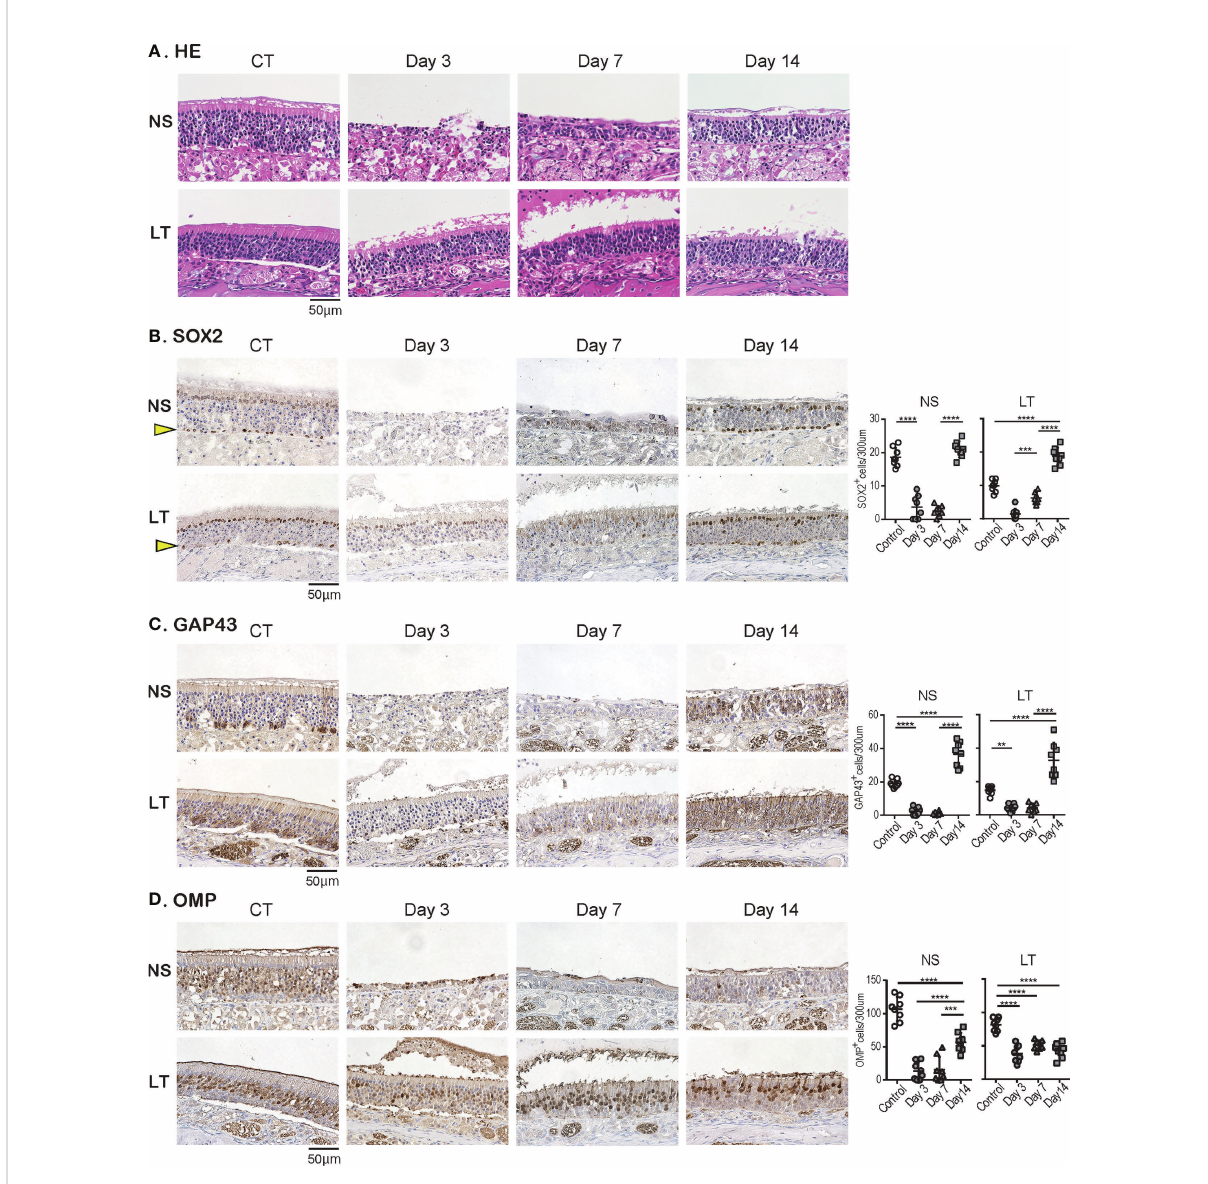
FIGURE 4 Effects of SARS-CoV-2 infection on the olfactory receptor neuron lineage. (A) Representative hematoxylin and eosin staining (HE) images of the olfactory epithelium in control (CT) hamsters and SARS-CoV-2 hamsters on days 3, 7, and 14. (B-D) : Representative images of immunohistological staining in CT and SARS-CoV-2 hamsters. Nasal septum (NS) area and lateral turbinate (LT) area are shown in magni fi ed view. Sex-determining region Y-box 2 (SOX2) + progenitor cells (B) , growth-associated protein 4 (GAP43) + immature olfactory receptor neurons (ORNs) (C) , and olfactory marker protein (OMP) + ORNs (D) are shown in brown. The basal layer is indicated by arrows. Tissue sections were counterstained with the nuclear dye hematoxylin (blue). Numbers of SOX2 + ORN progenitors per 300 m m of the basal layer, and GAP43 + immature ORNs and OMP + mature ORNs per 300 m m of olfactory epithelium in each area are counted in CT or SARS-CoV-2 hamsters. ** P < 0.01; *** P < 0.001; **** P < 0.0001. SARS-CoV-2, severe acute respiratory syndrome coronavirus